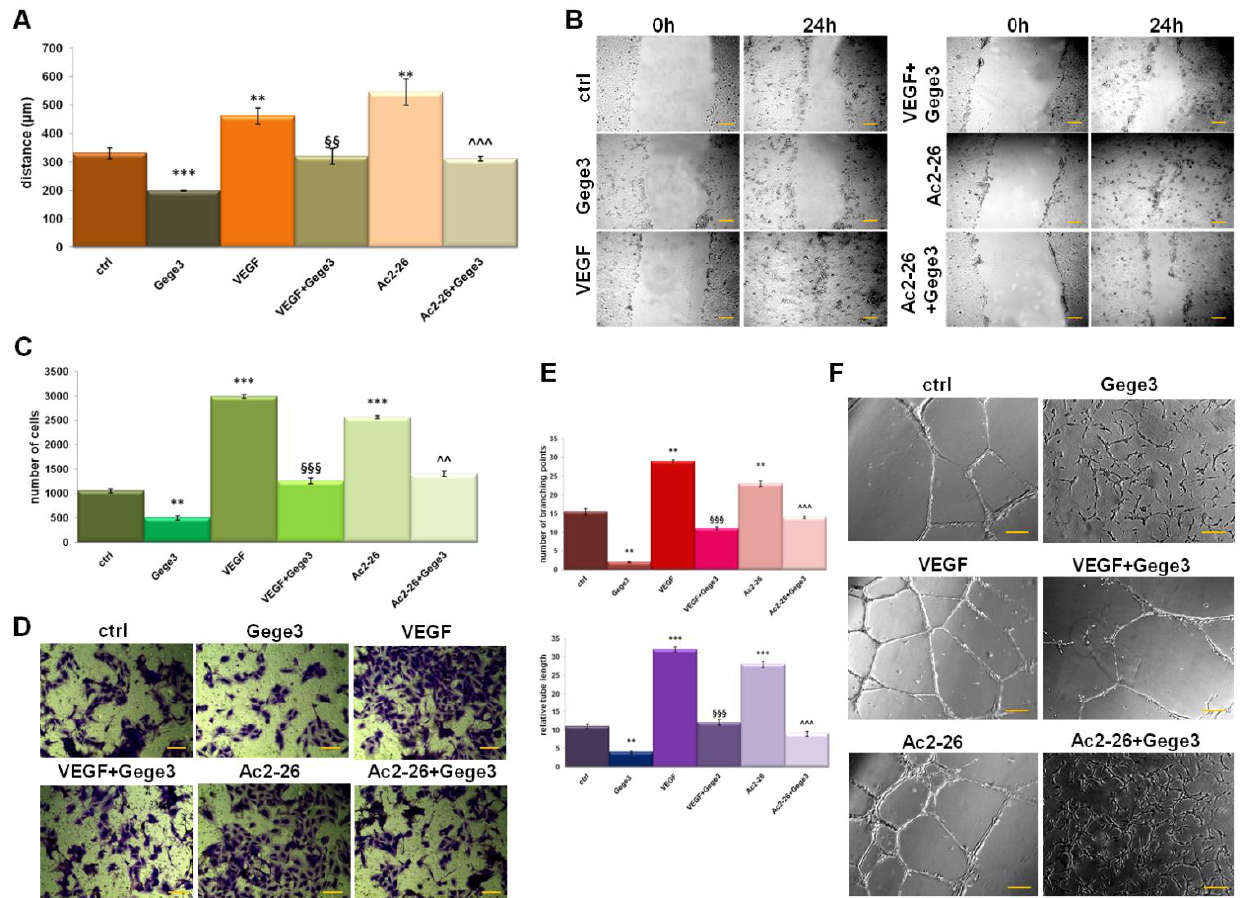
Figure 1. Effects of Gege3 on HUVEC cells. ( A ) Migration, ( C ) invasion speed, and ( E ) in vitro angiogenesis of HUVEC cells treated with VEGF 10 ng/mL, Ac2-26 1 µM, Gege3 10 µM. Each kind of evaluation has been accompanied by representative bright-field images (( B ) for wound healing, ( D ) for invasion, and ( F ) for angiogenesis). The angiogenesis has been evaluated through the tube length and the number of branches calculated by ImageJ (Angiogenesis Analyzer tool) software. Histograms and representative bright-field images for each assay are reported. The bars of each bright-field image are 50 μm. Data represent the mean of four independent experiments ± standard deviation with similar results. ** p < 0.01; *** p < 0.001 for treated cells vs. untreated controls; §§ p < 0.01; §§§ p < 0.001 for the point with VEGF+Gege3 vs. VEGF; ^^ p < 0.01; ^^^ p < 0.001 for Ac2-26+Gege3 vs. Ac2-26.